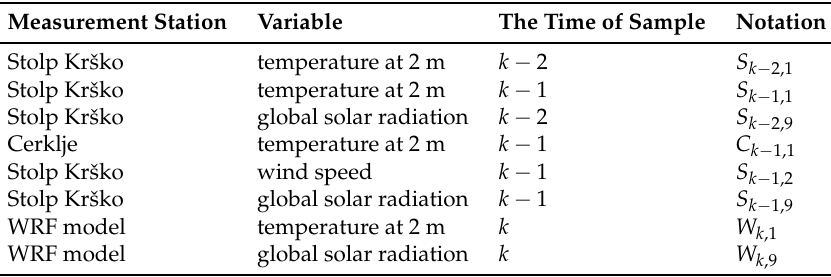
Table 1. The nonlinear functional dependence of variable S k ,1